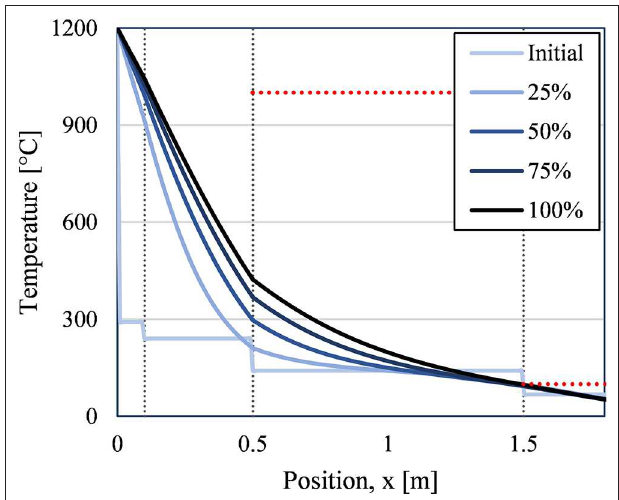
FIGURE 7 | 1D temperature profiles from storage step (120h) for different points in time for an acceptable case (Refractory A = 0.1m, Refractory B = 0.4m, CaSi = 1.0m, concrete = 0.305m). Vertical lines mark changes in insulation material. Horizontal red lines mark material temperature limits for CaSi (1,000 ◦ C) and concrete (100 ◦ C).